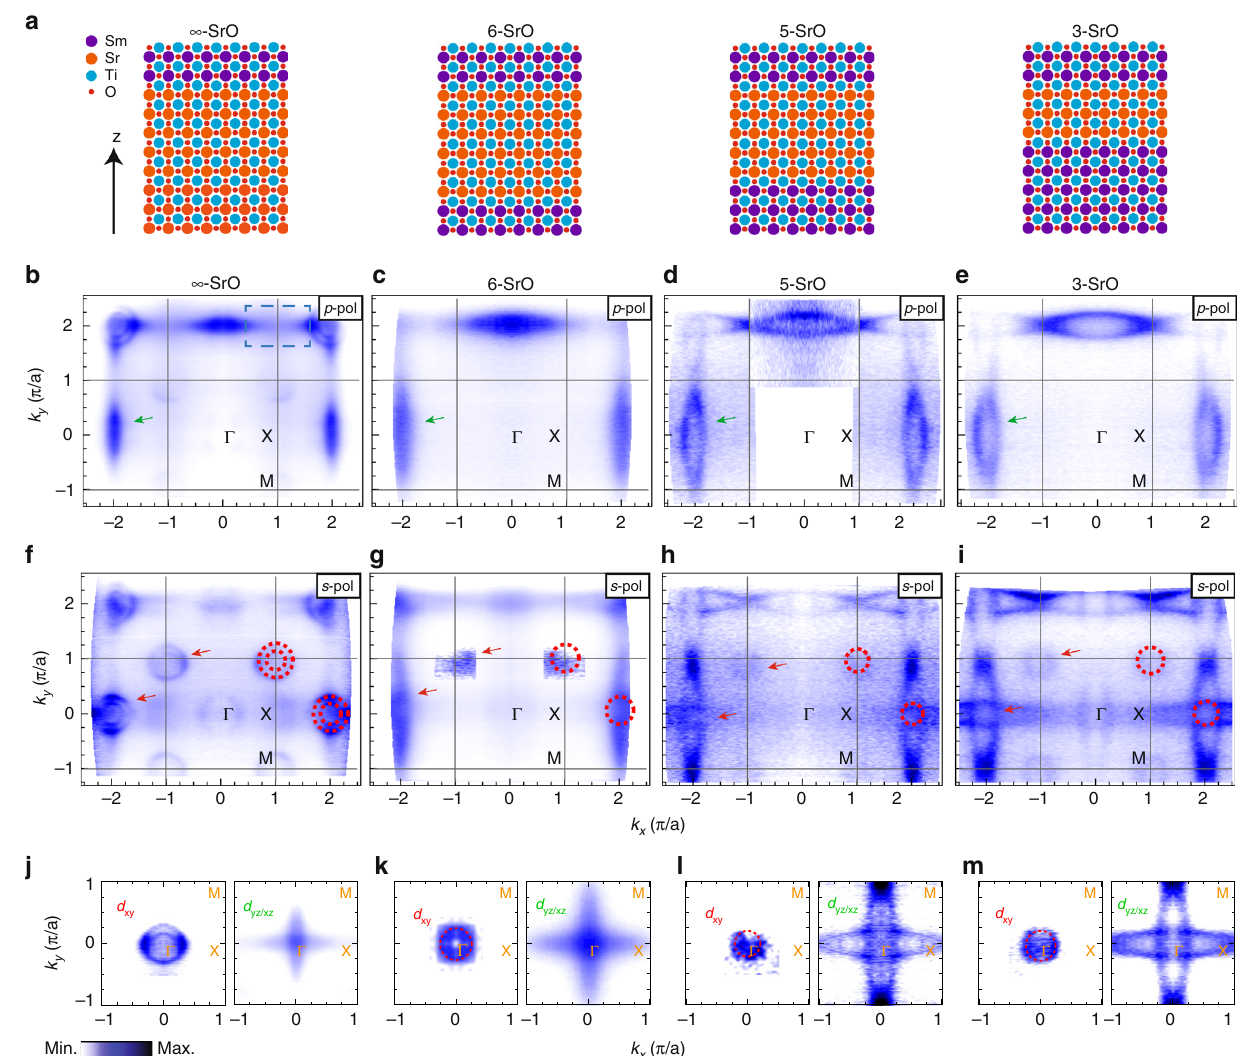
Fig. 1 Overview of the heterostructures and evolution of the interface Fermi surfaces. a The schematics of heterostructures studied in this work. Under the t top capping layers of SmTiO 3 (two quasi-unit cells), x layers of SrTiO 3 are embedded. The thickness of SrTiO is de fi ned by the number of SrO layers 3 QW ¼ 1 , 6, 5, and 3-SrO structures are shown, respectively. Fermi surface maps at E ( x -SrO). From left to right, t for different quantum well states taken QW F ¼ 1 ( b , f ), 6 ( c , g ), 5 ( d , h ), and 3 ( e , i )). Spectra are obtained by integrating intensities in the energy window of ±10 meV at E over multiple BZ: t F . Data QW are taken with two polarization ( p – polarization in b – e , and s – polarization f – i ,). The black solid line represents the in-plane BZ of SrTiO 3 with high symmetry points marked. The green arrows (red circulars and red arrows) are guides to the eye for the Fermi surface of d yz = xz ( d xy ) orbital. Zoom in of Fermi surface ¼ 1 ( j ), 6 ( k ), 5 ( l ), and 3 ( m ), obtained by symmetrization and/or summarization of structures for each Ti d orbital, d xy (left) and d yz = xz (right) for t QW equivalent BZ. The dashed red circular contours are guides to the eye as the Fermi surfaces of d xy orbital. For a direct comparison, all Fermi surfaces shown here are centered at ð k x ; k y Þ ¼ ð 0 ; 0 Þ , and shown in a range corresponding to the BZ of SrTiO 3 . (black solid line) indicates greater mass enhancement factors dashed square in Fig. 1b) for the different layers. For the 1 -SrO (1 = Z ). The effective mass of d (Fig. 3a), the d orbital bands clearly shows state forms a closed Fermi surface, forming an yz = xz yz = xz signi fi cant enhancement for the 5- and 3-SrO systems, while the isolated small electron pocket centered around the Γ point as also effective masses in 1 - and 6-SrO are described as the bare band seen in Fig. 1b, and hence absence of electronic states in the mass ( Z ’ 1). Such enhancement of the mass renormalization proximity of the X point (see also the dispersion curves in Fig. 3k, state and hence electron correlation can be explained by the increase of l). Once the thickness of SrTiO 3 changes to 6-SrO, the d yz = xz electron doping in each TiO 2 layers. Indeed, as the distance evolves to have a larger Fermi surface and a deeper bandwidth as between interfaces decreases, more electrons are con fi ned in the discussed in Figs. 1 and 2, and the topology of the Fermi surface is narrower and fl atter quantum potential, resulting in a signi fi cant the same as the 1 -SrO (a closed electron pocket centered around increase of electrostatic doping level. the Γ point). On the contrary, as the number of layers decreases (cid:4) 5SrO, the size of the electron pocket at the Γ point expands t QW eventually covering the entire BZ, till the X point, see Fig. 3c, d. Lifshitz transition and emergence of Van Hove singularity . In This gives rise to a hole-like structure along Γ -X direction (light- Fig. 3, we study the details of the electron pocket and Fermi blue dashed line), and electron-like structure along the other surface topology near the BZ boundary (the X point, see blue NATURE COMMUNICATIONS| (2019) 10:5534